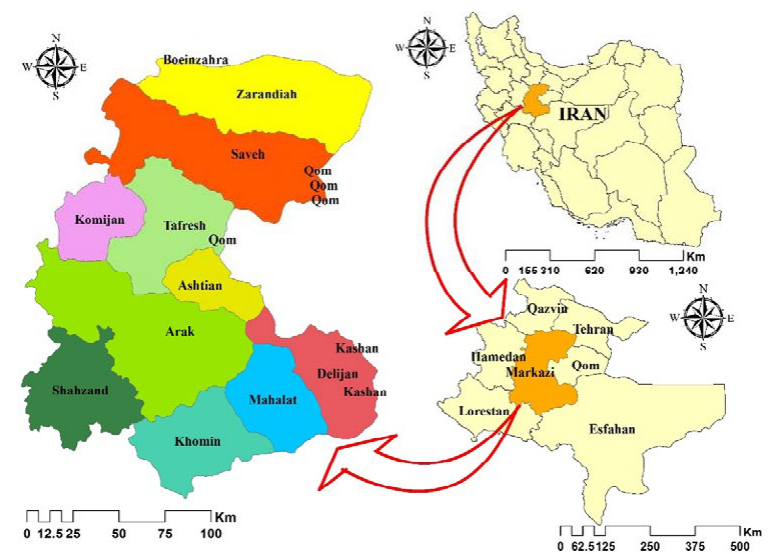
Fig. 1: Location of Markazi province in Iran